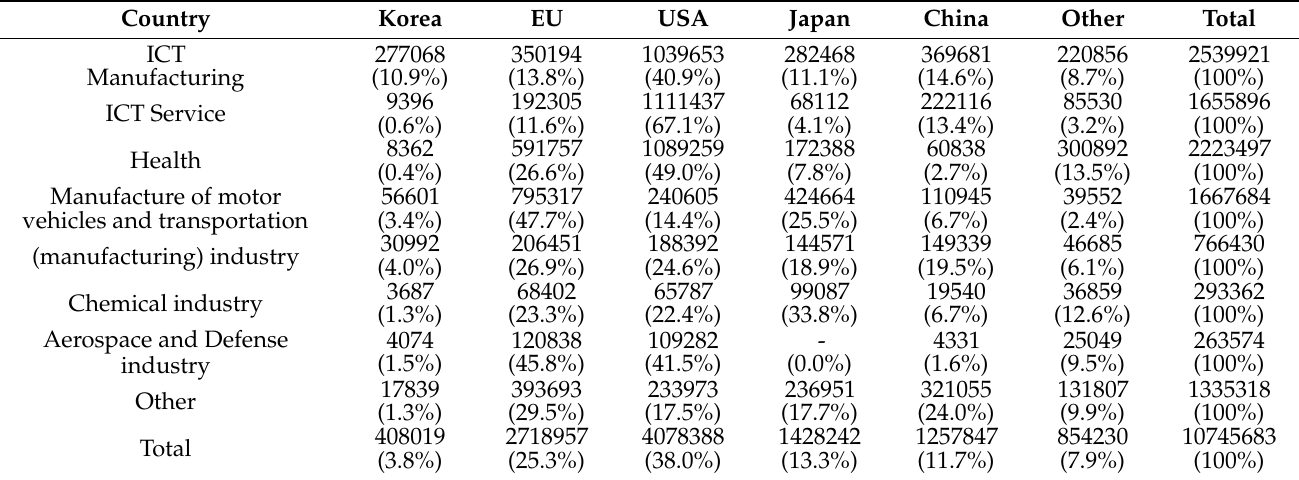
Table 6. R&D investment by industry and share by country